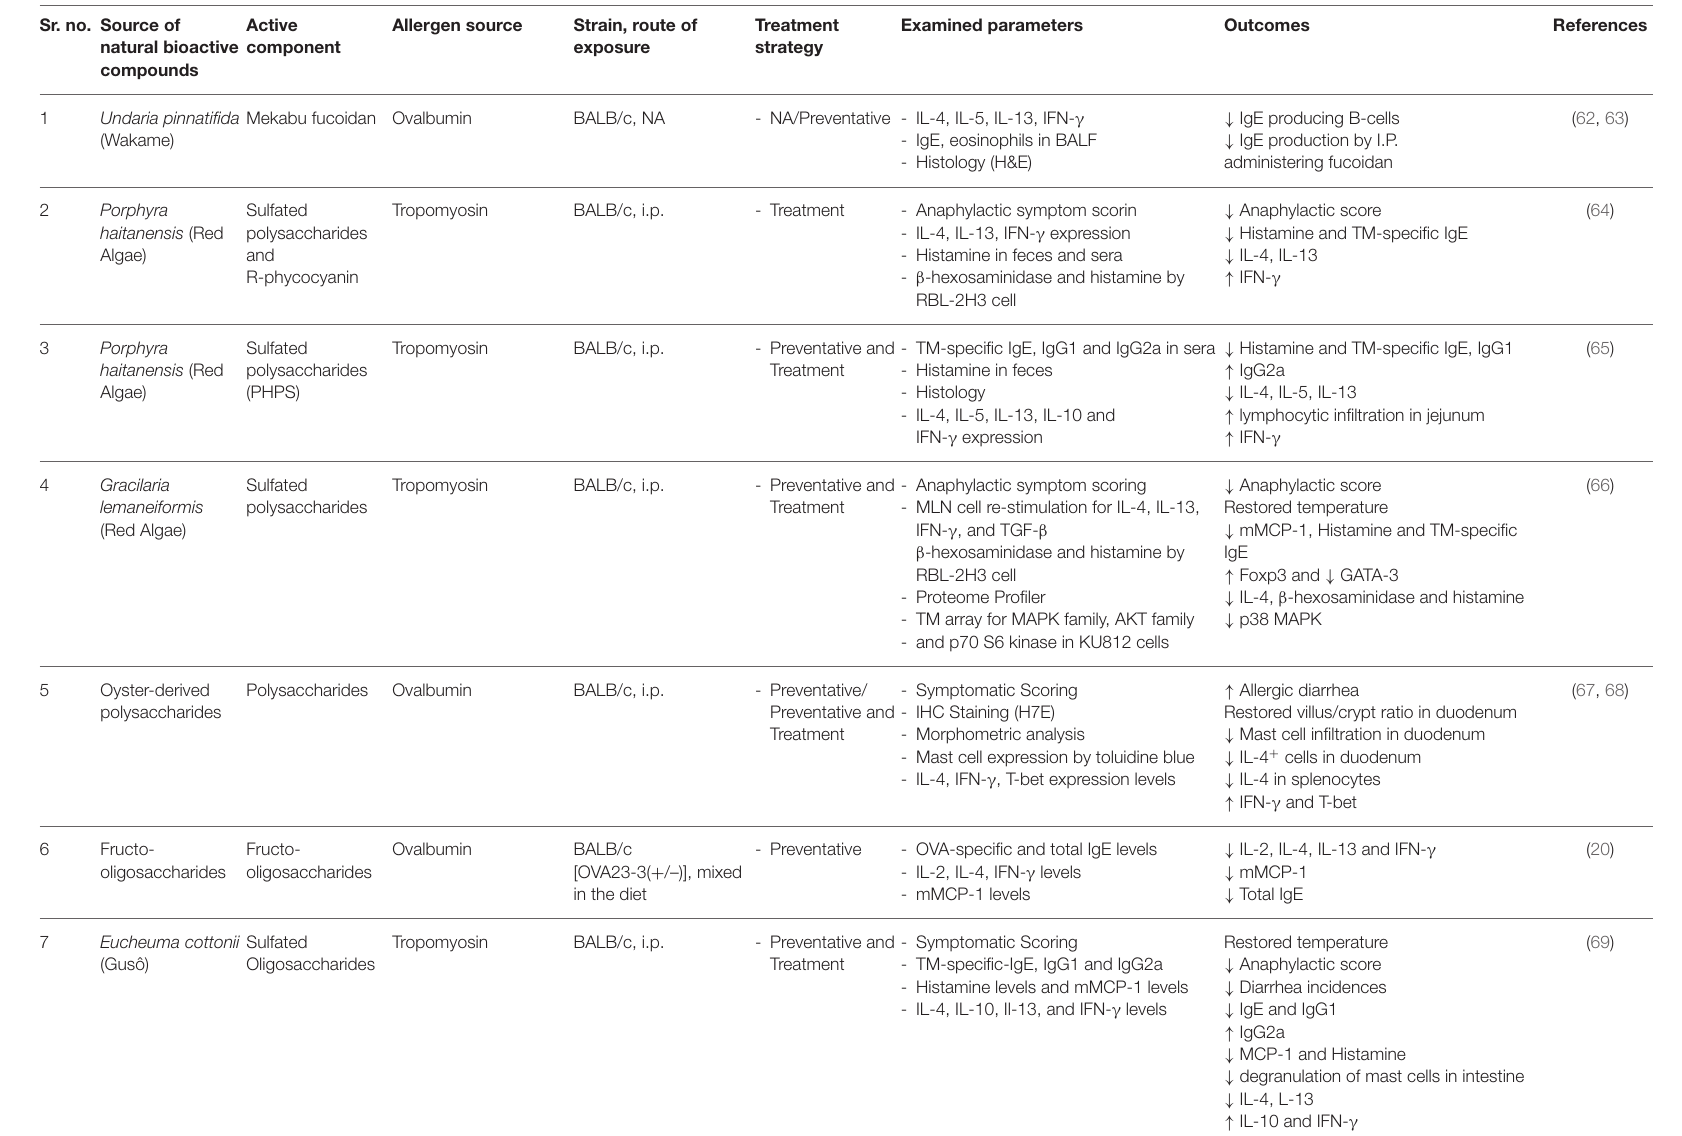
TABLE 1 | A summary of studies investigating the immunomodulatory effects of active oligo- and polysaccharide components from various natural sources, tested for preventative (prophylactic) or treatment (curative) strategies, using mouse models of food allergy. Sr. no. Source of natural